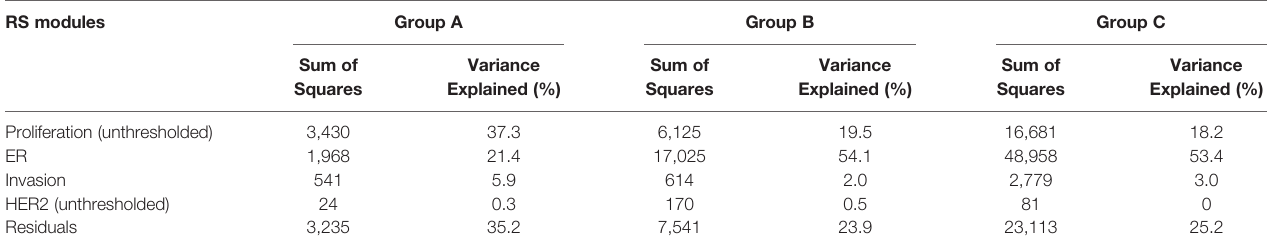
TABLE 2 | The variance of RS as accounted for by individual